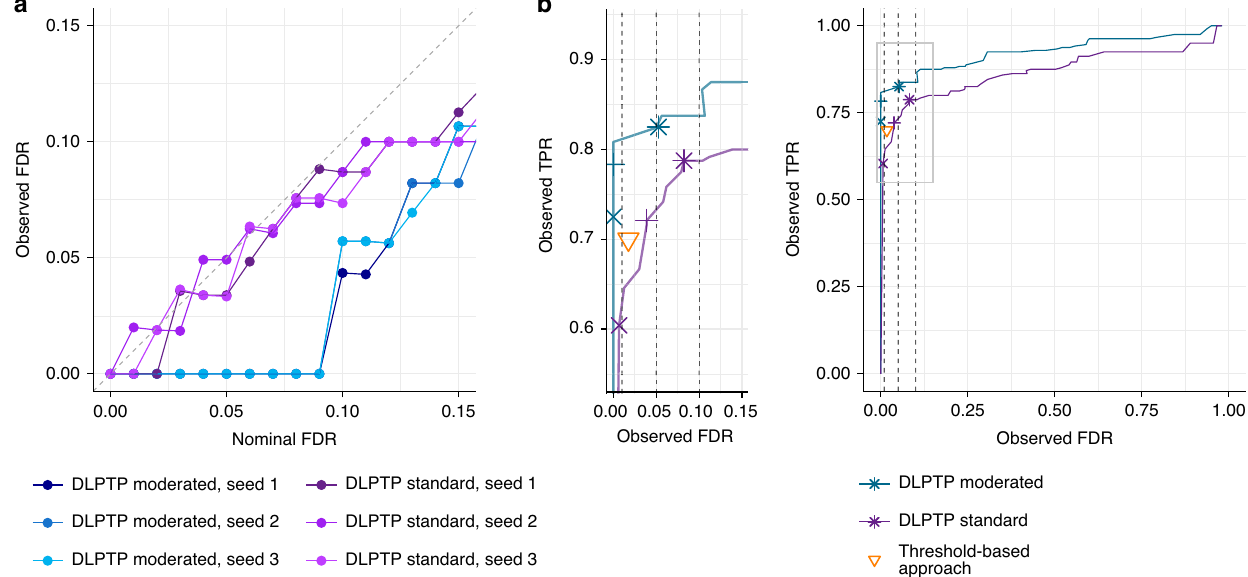
Fig. 2 Benchmarking of DLPTP on a synthetic dataset con fi rms FDR control and high sensitivity. a Observed FDR versus nominal FDR for 3 random seeds for bootstrapping ( B = 100) with the standard and moderated DLPTP method applied to a synthetic dataset. b Observed TPR versus observed FDR curves for the standard and moderated DLPTP method and the threshold-based approach. Shown is the average of three different random seeds for both DLPTP methods with 100 bootstraps. Vertical lines correspond to observed FDR at 1, 5, and 10%, x represents results obtained with different DLPTP versions at 1%, + at 5%, and * at 10% nominal FDR. FDR: false discovery rate; TPR: true positive